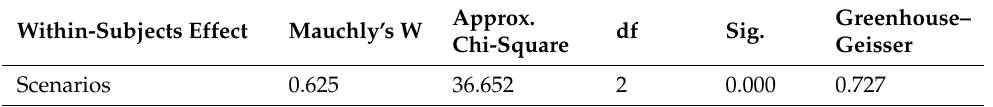
Table 8. Mauchly’s test of